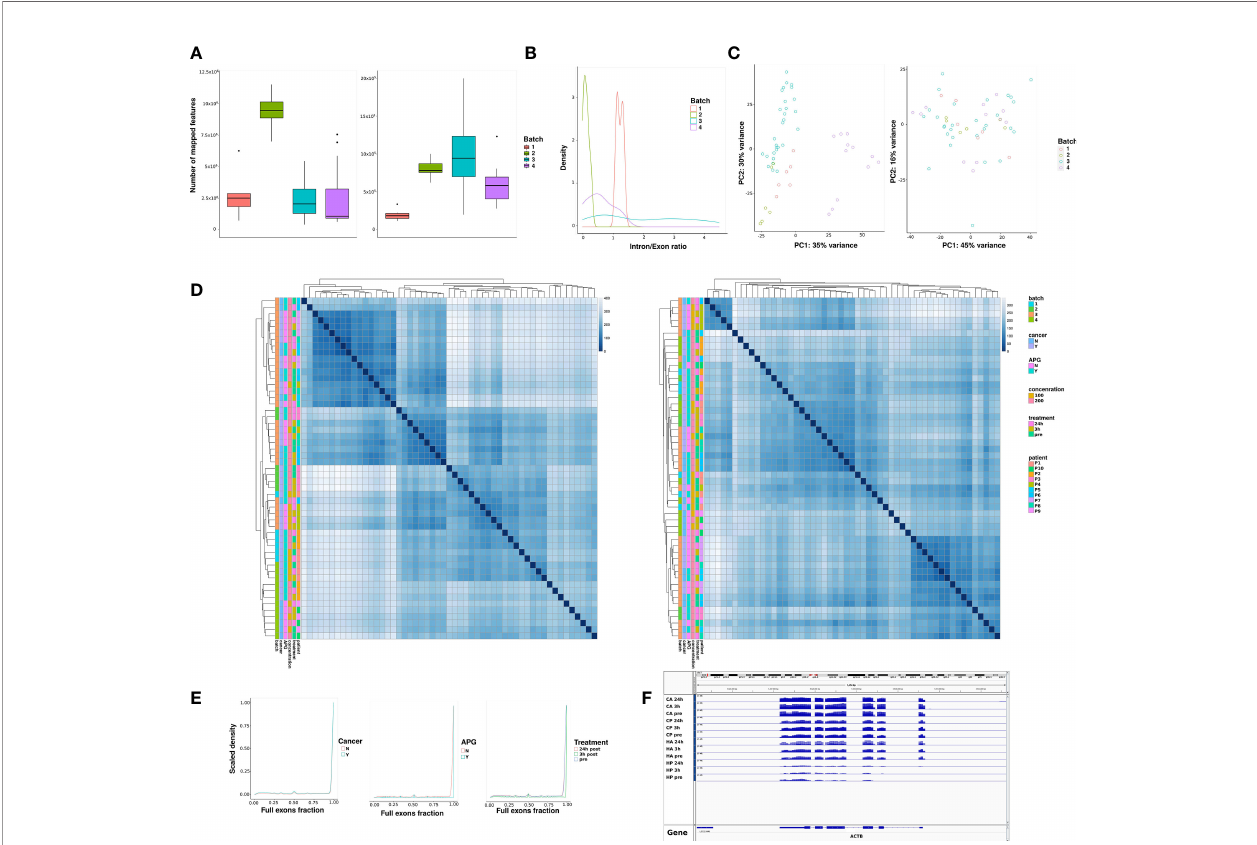
FIGURE 1 | Characteristics of the sequencing runs. Samples were run in four batches under different conditions. (A) Number of sequencing reads mapping to features of interest (exons) per sequencing batch, non-corrected (left), after mitochondrial transcript removal (right). (B) Intron to exon ratio per sequencing batch. (C) Principal component analysis after normalization and variance-stabilizing transformation of samples before (left) and after batch correction (right). (D) Distance matrices between samples before (left) and after (right) batch correction. Each row and column represent a single sample, and the diagonal represents samples that are identical. A higher distance score represents higher dissimilarity between a pair of samples. Sample annotation is shown by multiple variables, such as: batch, whether a patient has cancer or not, whether they received 100mg or 200mg of APG-157 or Placebo, treatment time point and patient ID. We have included the same batch and cross-batch technical replicates for a portion of the samples. (E) The distribution of exon occupancy across all genes with 2 or more exons; a value of 1 means full occupancy; a value between 0 and 1 means partial exon occupancy; genes with no exon occupancy have been removed from the dataset. (F) An IGV screenshot showing the coverage of ACTB as a representative gene with full exon